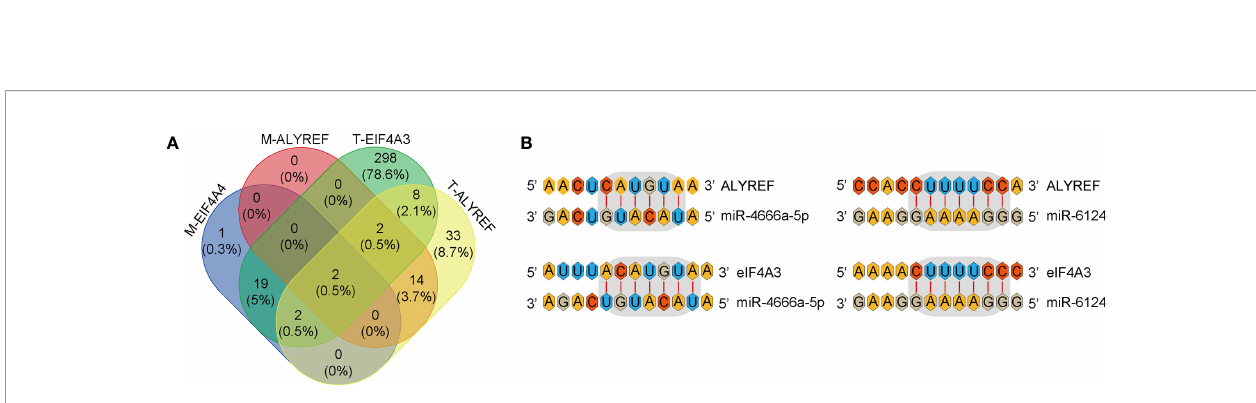
FIGURE 7 | Identi fi cation of co-targeting miRNAs for ALYREF and eIF4A3. (A) A Venn diagram showing the possible overlap in miRNAs between ALYREF and eIF4A3. (B) miR-4666a-5p and miR-6124 may both interact with ALYREF and eIF4A3 binding